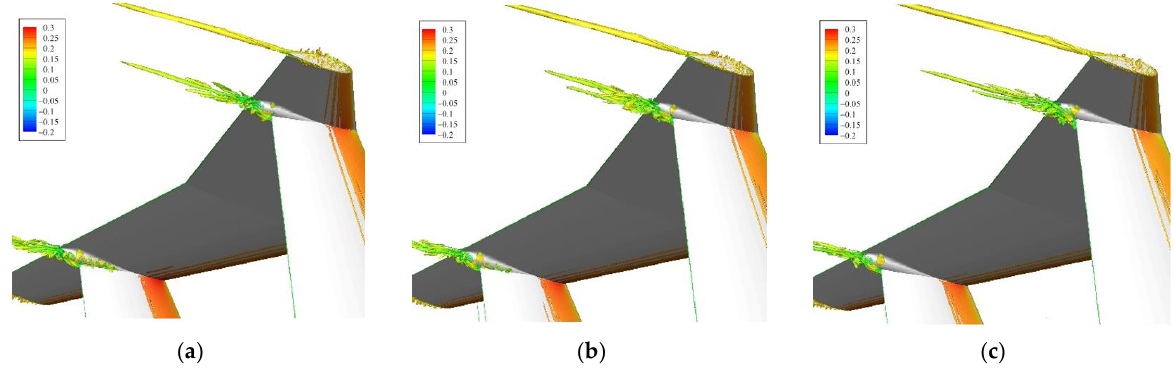
Figure 19. Ω = 0.52 isosurface , looking from the pressure side of modified model: β = ( a ) 0°, ( b ) 2°, and ( c ) 4°.